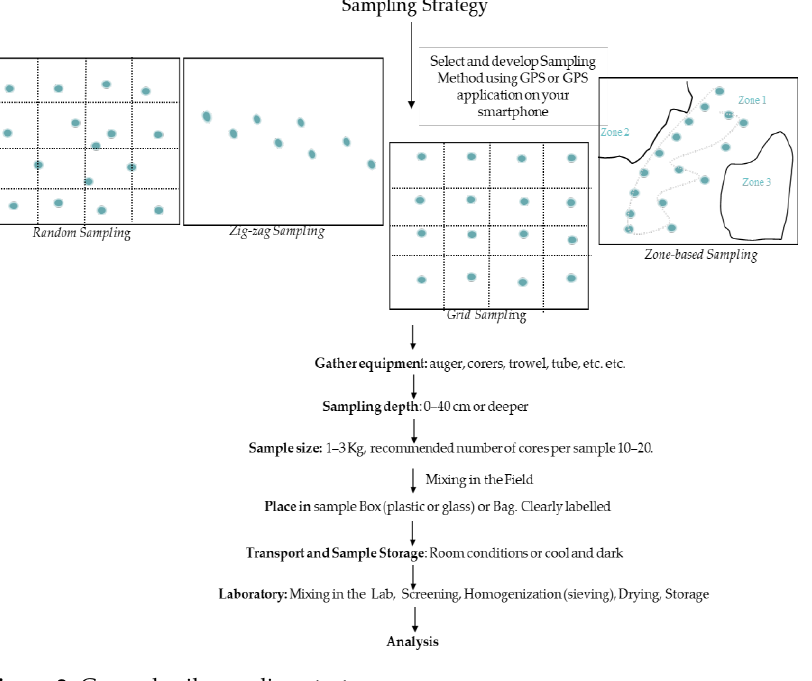
Figure 2. General soil-sampling strategy.